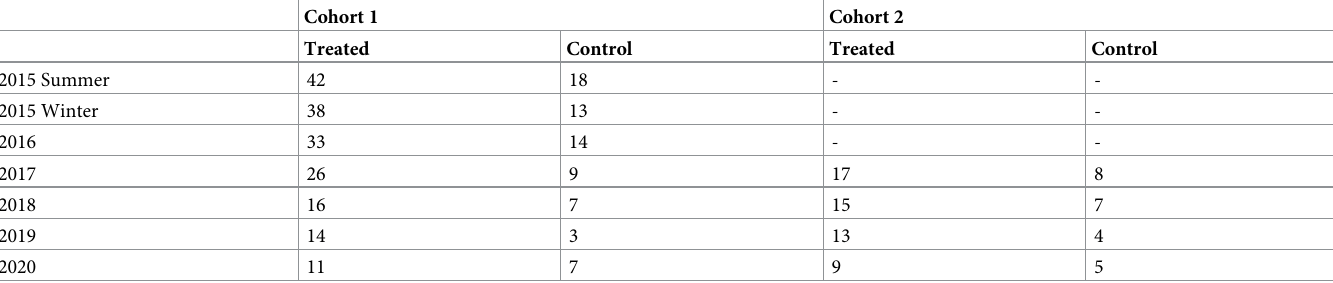
Table 1. Schedule of sampling and number of female feral cattle sampled at each stage in Cohorts 1 and 2. Cohort 1 Cohort 2 Treated Control Treated Control 18 - -